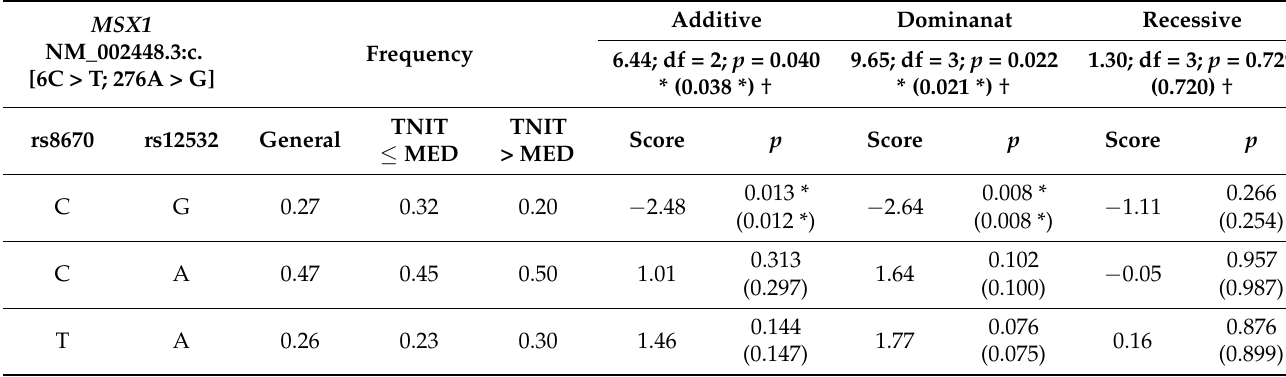
p —values calculated for haplotype frequencies, comparisons between the subgroup of patients with a total number of impacted teeth below the median value (TNIT ≤ MED) and the subgroup of patients with a total number of impacted teeth above the median value (TNIT > MED), minimal haplotypes’ frequency taken into account during analyses—5%, values corrected according to the sex are given in parentheses, score—magnitude and direction of effect, †—global significance test, * statistical significant difference p <